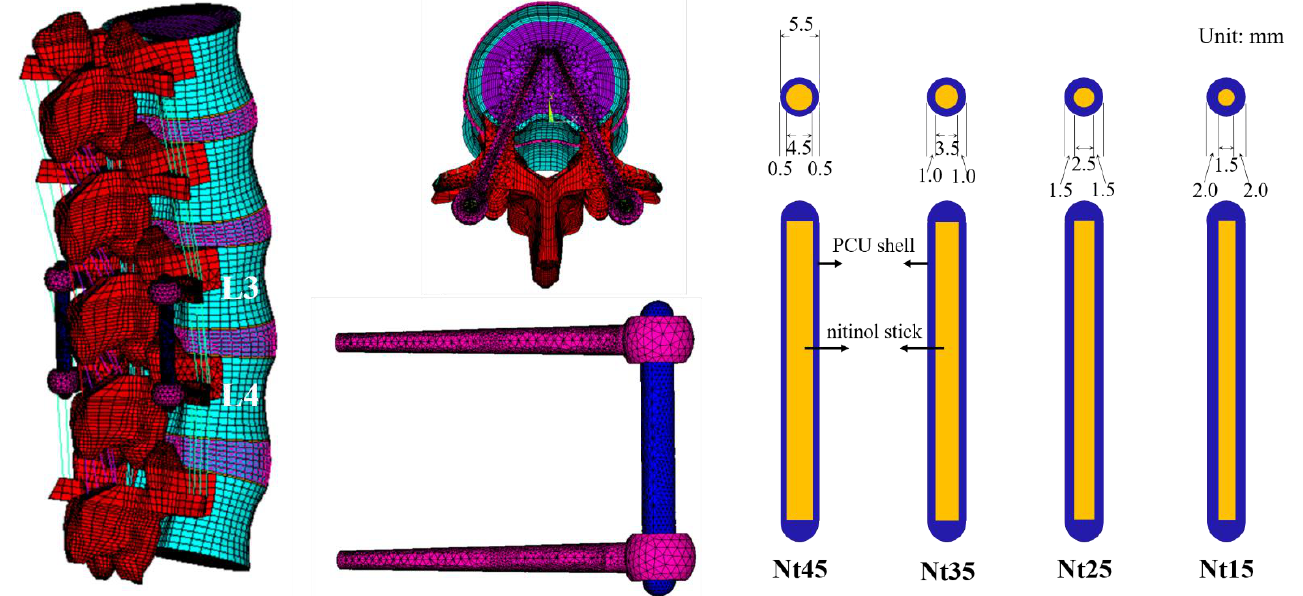
Figure 1. Overview of the finite element model and SHE rod dynamic stabilization system. Systems with different NS diameter/PS thickness ratios of the SHE rods were implanted into the L3–L4 spine model. Table 3. The elements and nodes of the five finite element models.